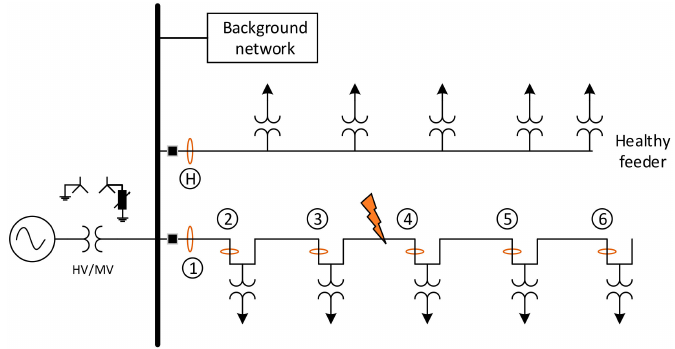
Figure 9. Cabled urban compensated